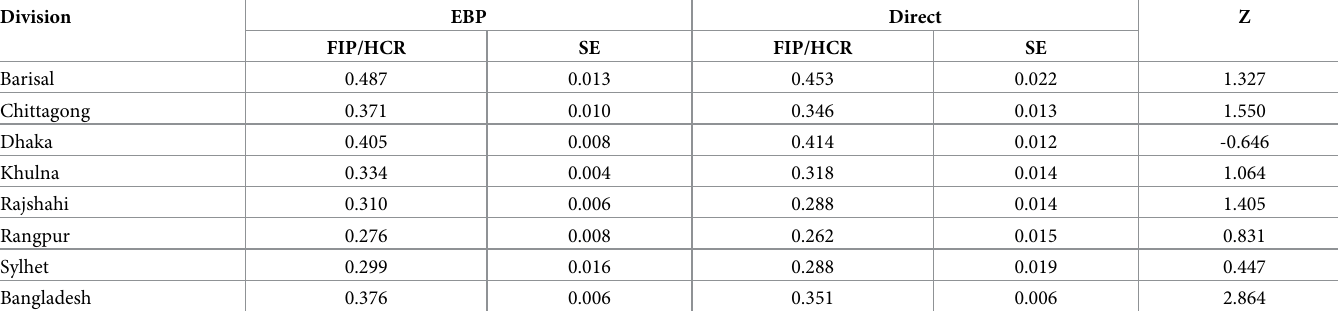
Table 3. Comparison of direct and EBP estimates of food insecurity prevalence (FIP/HCR) and their standardized difference.